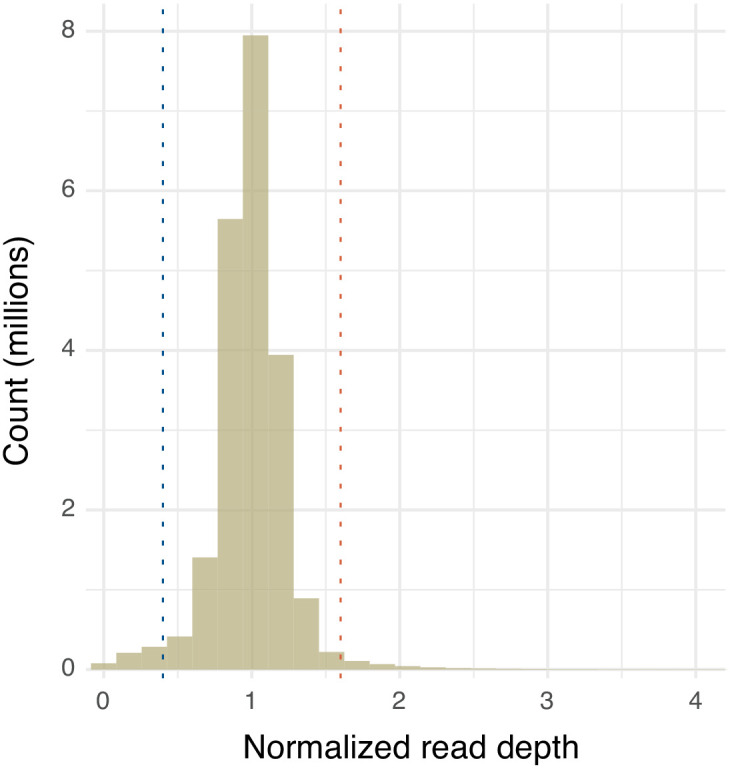
Normalized read depth distribution across C. parasitica isolates.